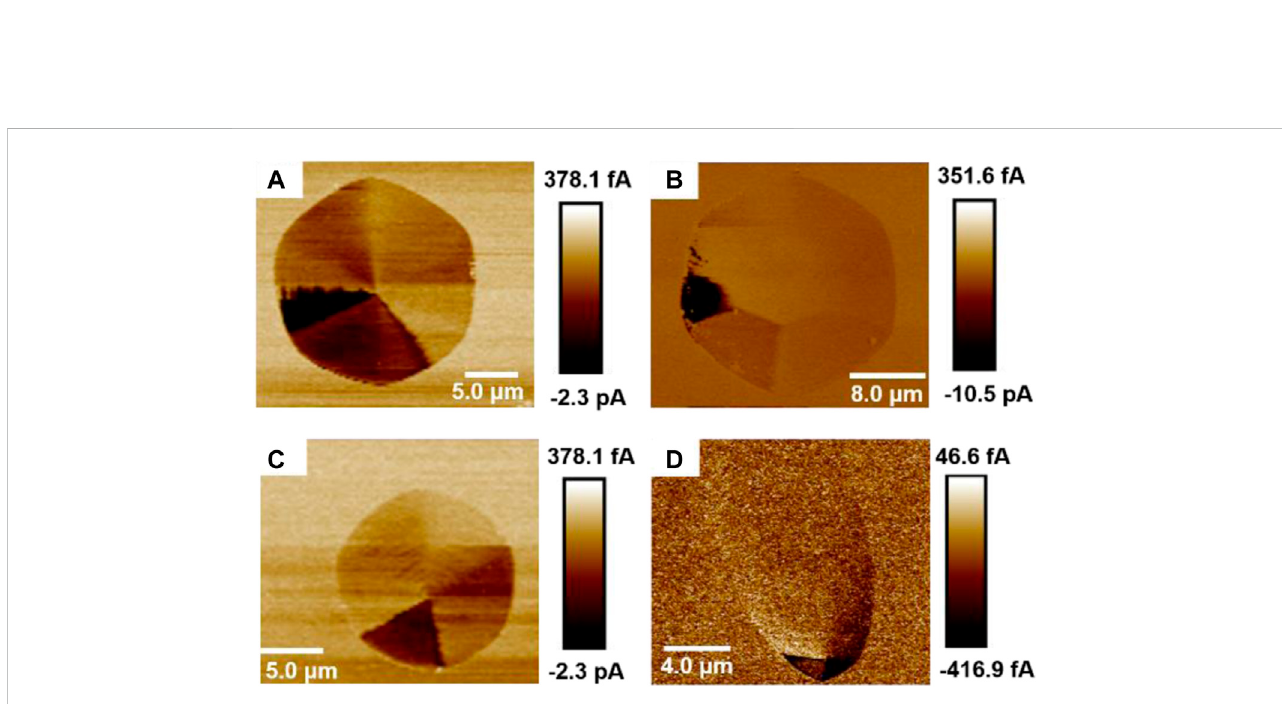
FIGURE 2 TUNA topography images of (A) TSD, (B) TMD, (C) TED, (D) BPD in 4H-SiC epitaxial layers.